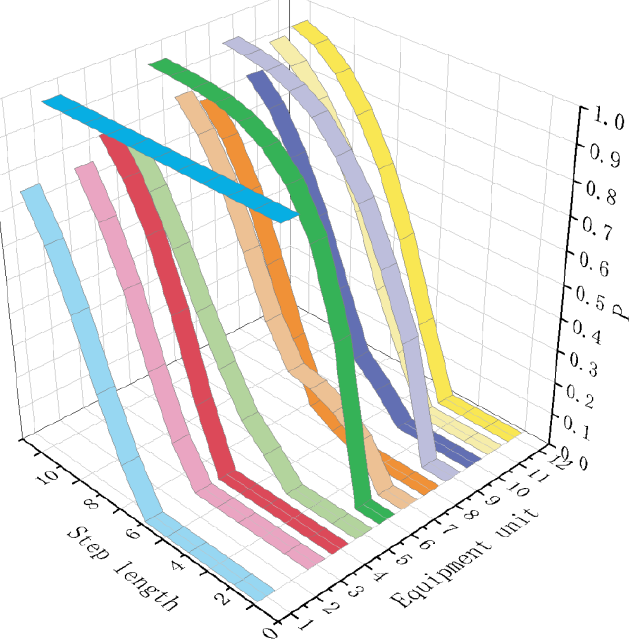
Figure 10. The fire probability of the equipment in the engine room changes at each time step when E2 is the initial fire source.